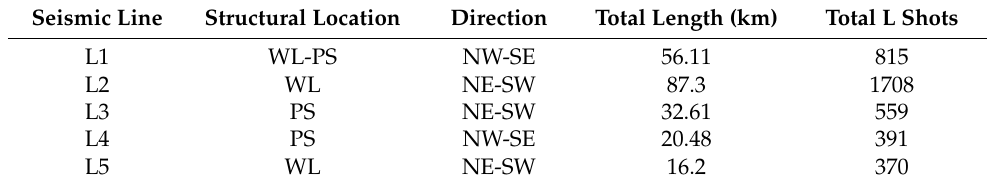
Table 2. Parameters of 2D seismic lines.